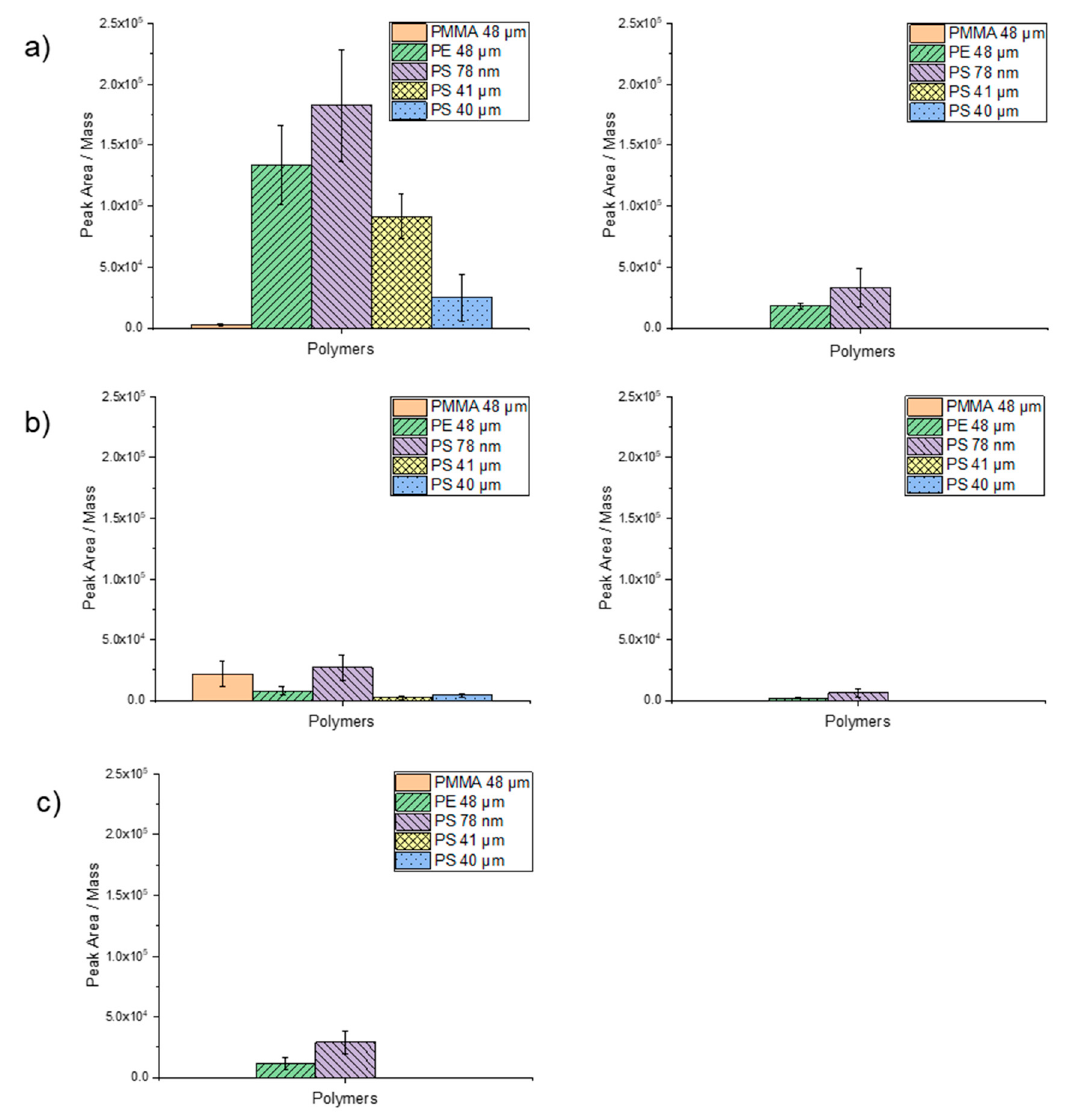
Figure 6. Sorption of the selected trace substances on PMMA (48 µ m), PE (48 µ m), PS (78 µ m), PS (41 µ m) and PS (40 µ m) particles: ( a ) 1 µ g / mL (left) and 0.1 µ g / mL (right) phenanthrene, ( b ) 1 µ g / mL (left) and 0.1 µ g / mL (right) α -cypermethrin and ( c ) 1 µ g / mL triclosan. For evaluation, the peak area of the trace substance was divided by the weighed mass.